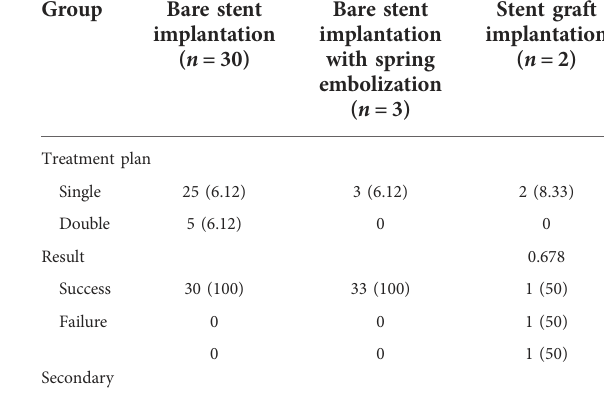
TABLE 6 Surgical data of endovascular treatment group.